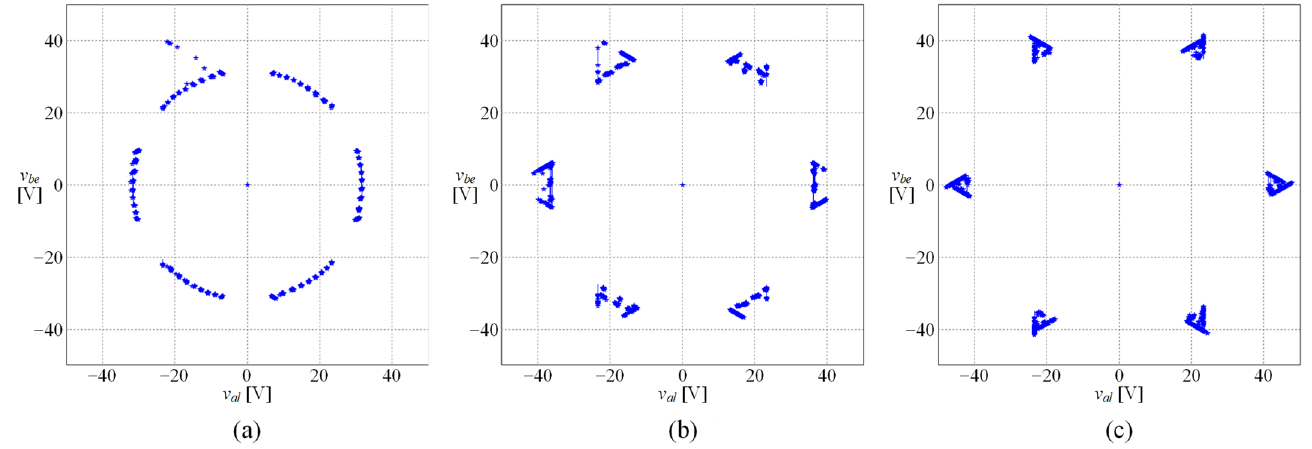
Figure 16. Voltage vector traces of proposed method at high MI: ( a ) At rotor speed of 1000 rpm (MI = 0.7); ( b ) At rotor speed of 1200 rpm (MI = 0.9); ( c ) At rotor speed of 1400 rpm (MI = 1.0).